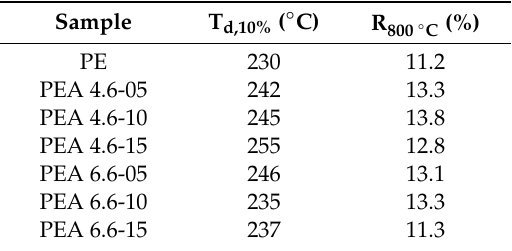
Figure 8. TGA thermograph ( a ) and dTG ( b ) of the cured resins. Table 5. TGA results of the cured